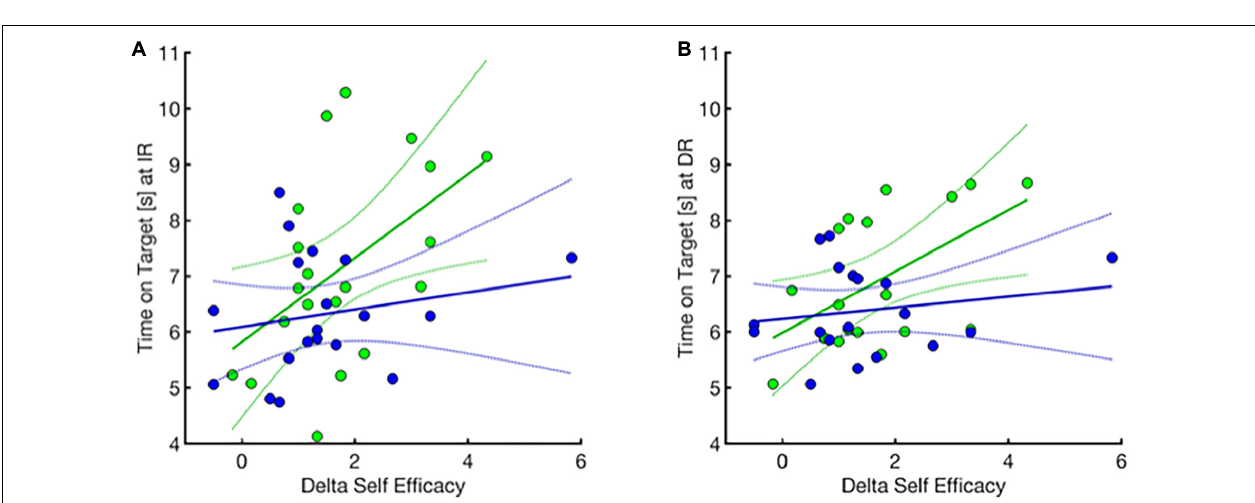
FIGURE 7 | Relationship of delta self-efficacy change ( x -axis) and motor performance ( y -axis) at immediate and delayed retention for motivation plus feedback (green) and feedback only (blue) groups. Pre to post practice change in self-efficacy is correlated with higher retention performance at immediate and delayed retention in the group that receives motivational statements in addition to performance feedback compared to feedback alone. (A) Immediate retention performance. Two participants had missing data and were excluded from data analysis. (1 missing pre-training time point, and 1 missing post-training time point, were removed from correlation analysis). (B) Delayed retention performance. Three participants had missing data and were excluded from data analysis. (3 missing delayed retention time point, were removed from data analysis). Dotted lines indicate the 95% confidence